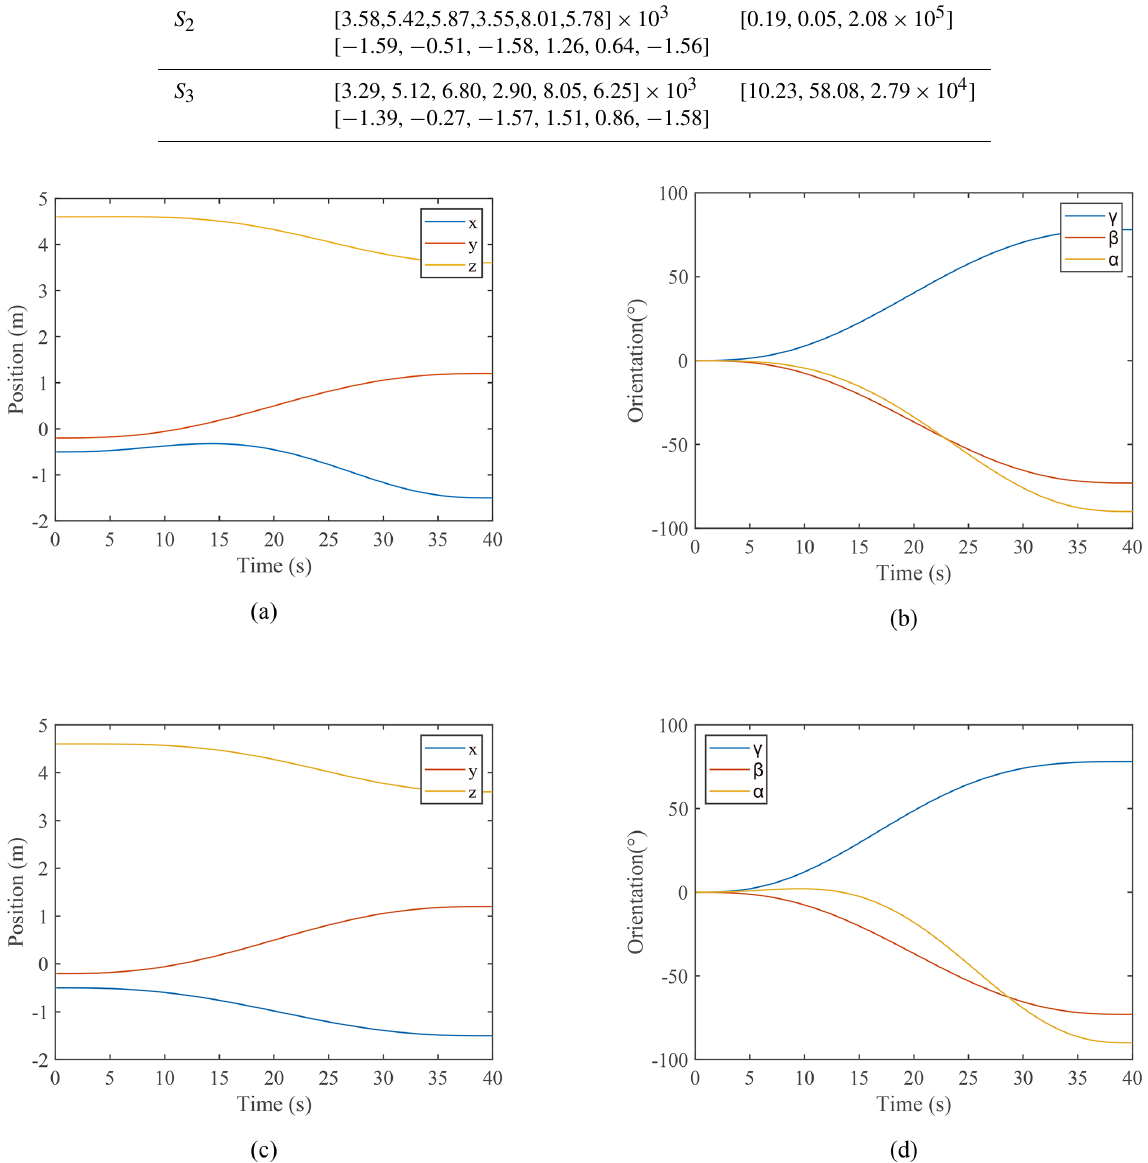
Figure 10. The position and orientation change of end effector. (a) The position changes of end effector in solution 2. (b) The orientation changes of end effector in solution 2. (c) The position changes of end effector in solution 3. (d) The orientation changes of end effector in solution